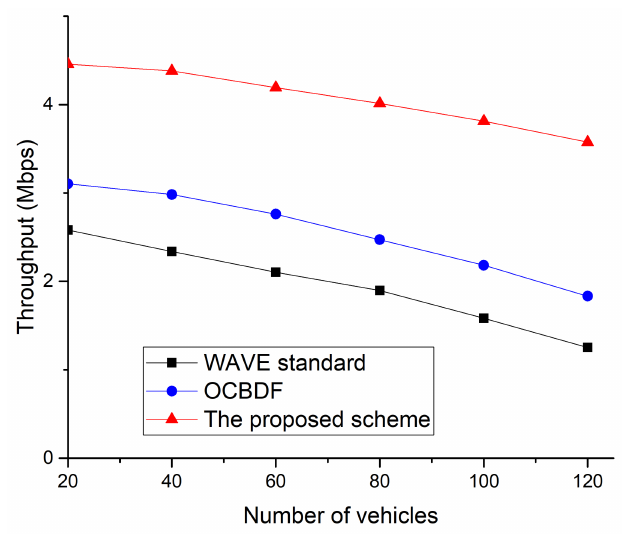
Figure 16. Throughput as a function of the number of vehicles.